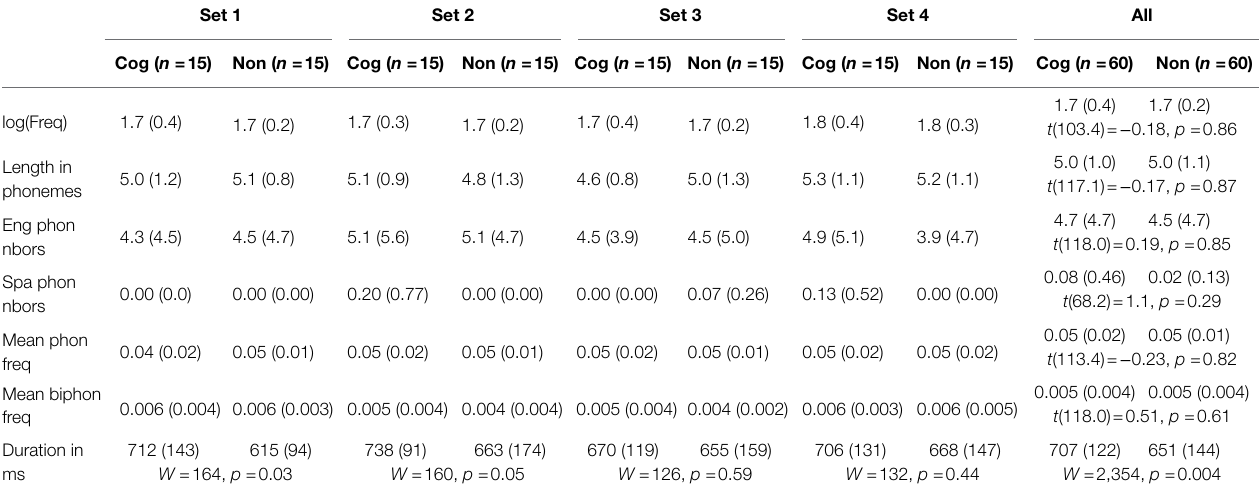
TABLE 2 | Summary of stimulus characteristics (means and SD s, real words